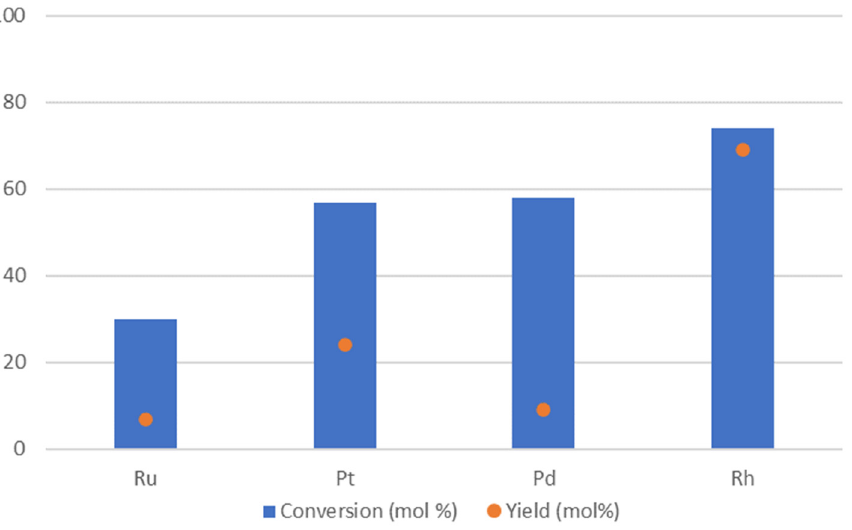
Figure 5. The conversion (mol%, blue) and yield (mol%, orange) of the hydrogenation reactions of cis , cis -muconic acid in presence of Ru, Pt, Pd and Rh NPs (metal = 0.037 mM) in water at room temperature and pressure with H 2 after 8 h of reaction.